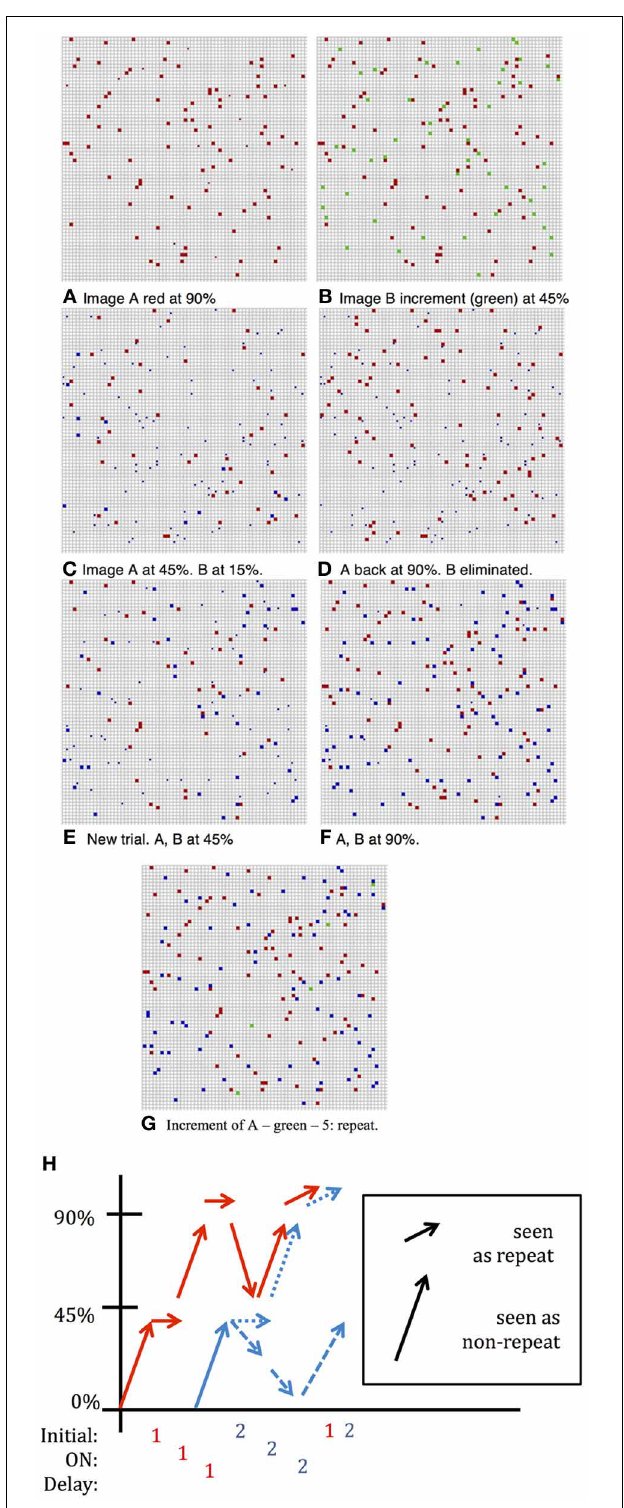
FIGURE 3 | DMS Simulation. Full squares—active selective units, small dots inactive selective units; color indicates neuron’s preferred image; fN ∼ 100. (A) Situation following presentation of first image and several